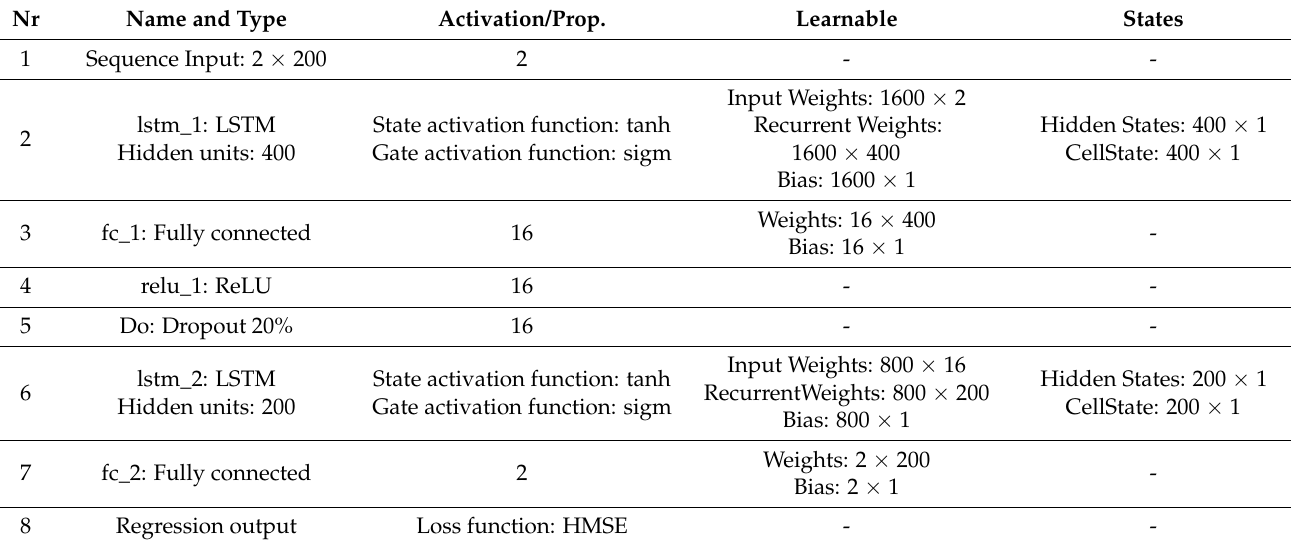
Table 4. Listing of neural network layer: s = 200 is the number of samples per input